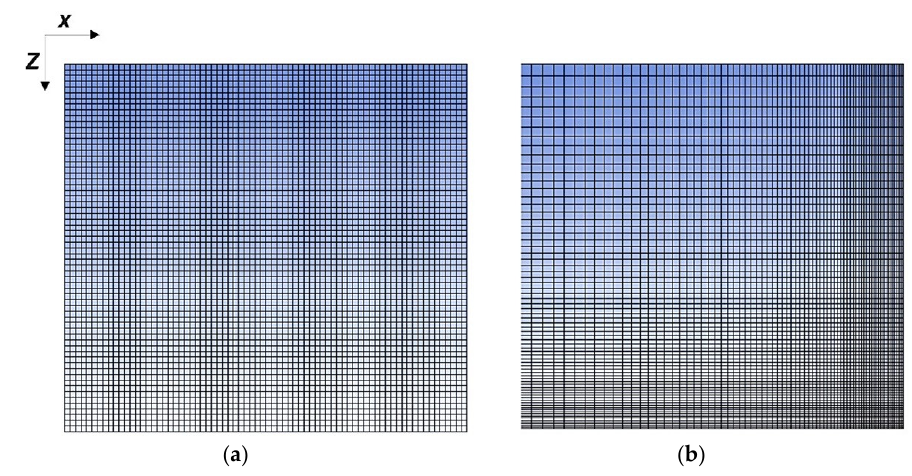
Figure 10. ( a ) Equidistant mesh. ( b ) Gradual change in the x and z directions. In the case of the wall’s surface, we apply only the equidistant grid. However, in the case of the cross section of the wall with an insulator, we apply both kinds of mesh: the equidistant and the non-equidistant. For programming simplicity, in a cross section, bricks always make up the left half of the cells, whereas the insulator (containing the ther- mal bridge) makes up the right half. This means that, in the equidistant case, the thermal bridge has the same thickness and volume as the insulator, but the thickness of the insu- lator is smaller (0.269 m) in the non-equidistant case, as shown in Figure 9B. The horizontal position of the thermal bridge is between x = 0.5 m and x = 1 m for the equidistant mesh and between x = 0.735 m and x = 1 m for the non-equidistant one. The height of the thermal bridge is two cells (2 cm) in the z direction, i.e., 0.02 m, while it is vertically positioned in rows number 20 and 21 from z = 0.37 m to z = 0.39 m. As in our previous work, we apply a resistance–capacitance-type model [38] of heat conduction, where it is necessary to switch to cell variables. The cell temperature is de- fined as the temperature in the middle of the cell. We calculate the heat capacity of the cells using the formula